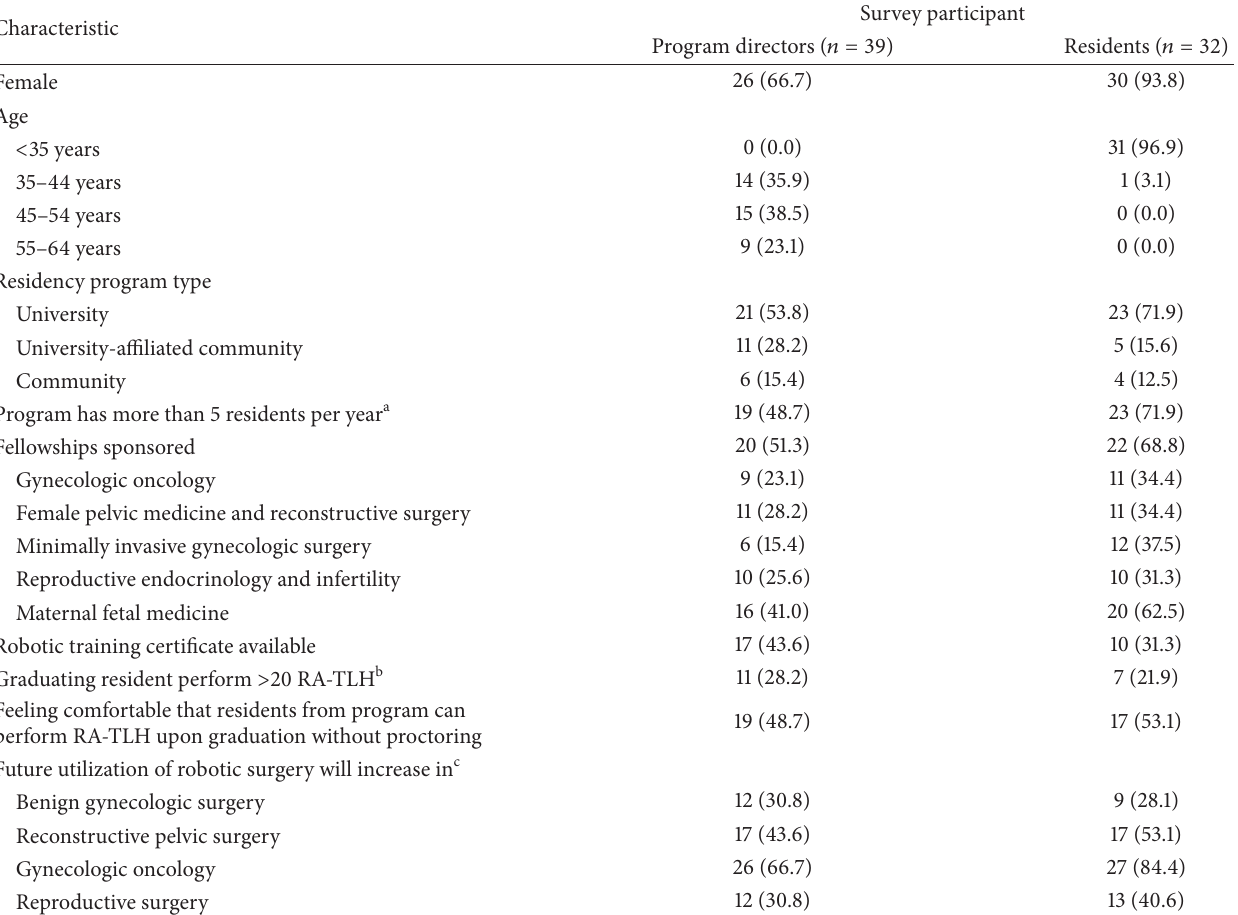
Table 1: Characteristics of residency programs, based on perceptions of residency program directors and of graduating obstetrics and gynecology residents.